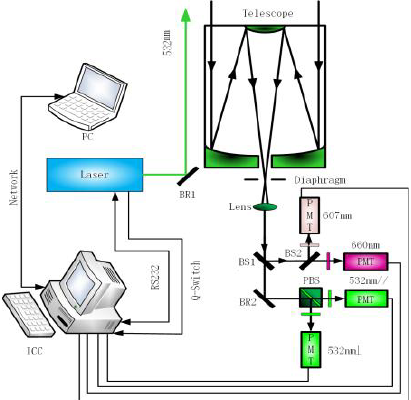
Figure 1 The schematic diagram and photo of WARL- (cid:266) Table 1 Specification of WARL- (cid:266)